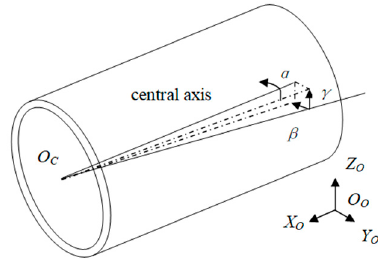
Figure 5. Diagram of small crane tube port pose.